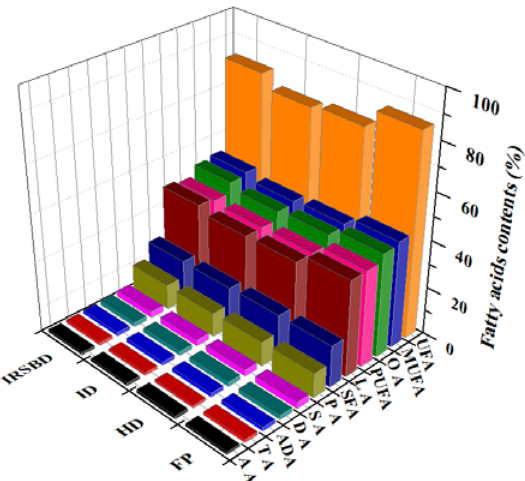
Figure 8. Changes in fatty acids during three drying methods.